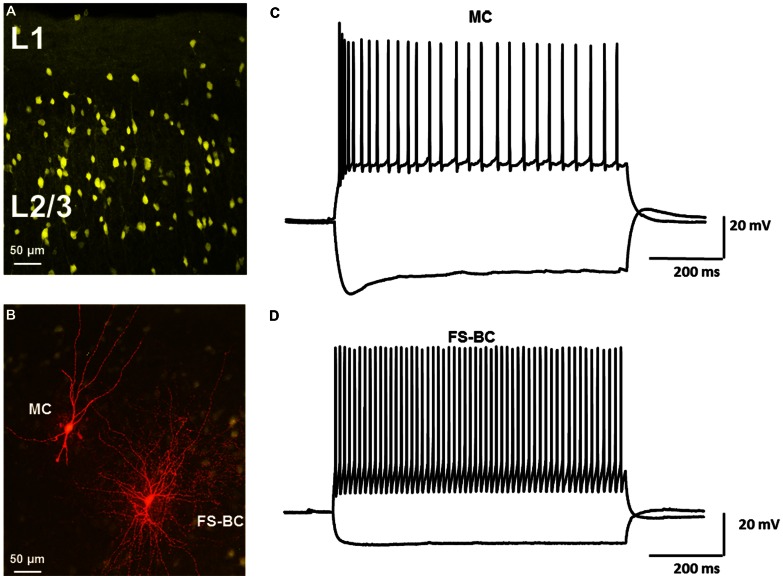
Identification of neocortical GABAergic interneurons in VGAT-Venus transgenic rats. (A) Confocal image of Venus-expressing interneurons in upper layers of rat neocortex. Morphologically distinct subtypes of interneurons can be identified. (B) Confocal image of Venus-expressing interneurons (yellow) and biocytin labeled interneurons labeled (red). Neurons were labeled with biocytin during whole cell recording. Distinct morphological differences were observed. Leftmost neuron had characteristics of a Martinotti cell (MC) whereas rightmost neuron was classified as a fast spiking basket cell (FS-BC). (C) Response of MC to depolarizing and hyperpolarizing current pulses demonstrate typical repetitive firing properties and prominent sag responses. (D) Representative response of FS-BC to depolarizing and hyperpolarizing current pulses. High frequency repetitive firing, prominent after hyperpolarizations and lack of a pronounced sag response were typical of fast spiking basket cells.